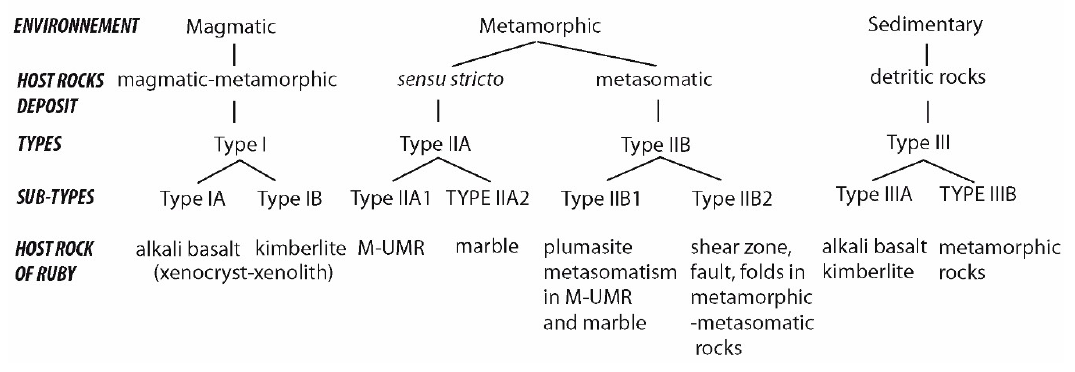
Figure 61. New typological classification for ruby occurrences and deposits worldwide. M-UMR = metamorphosed mafic-ultramafic rocks.